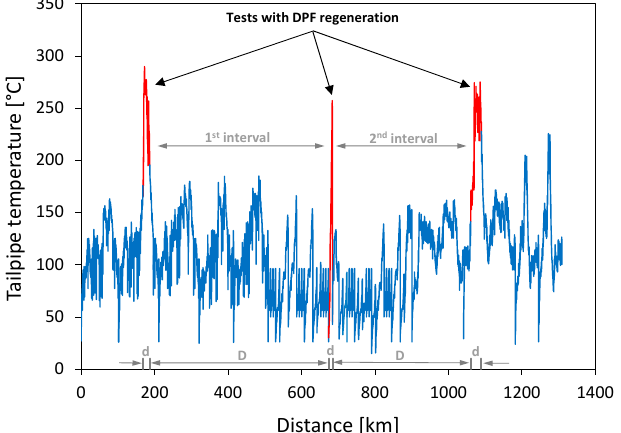
Figure 9. Consecutive DPF regenerations, as determined with the tailpipe temperature, used for the determination of the regeneration frequency.